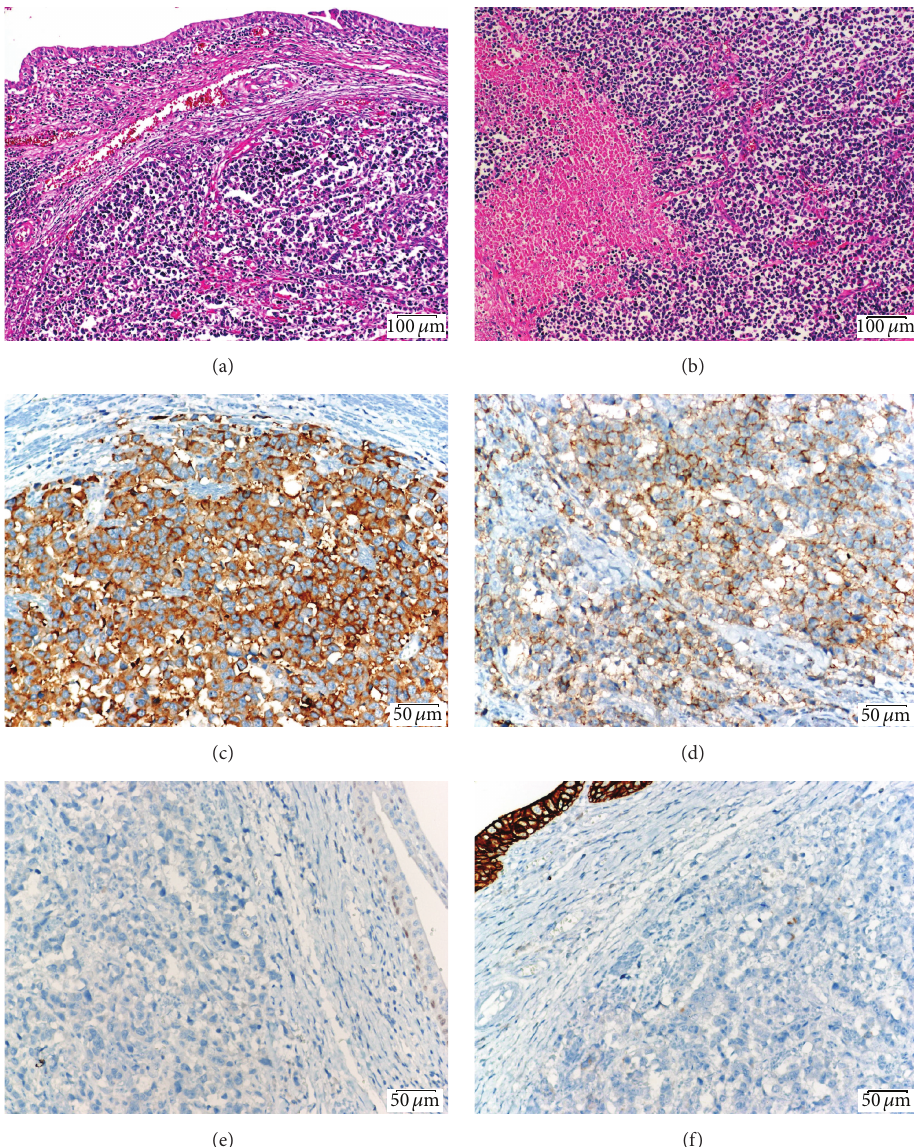
Figure 2: (a) Surface infiltrating urothelial lining laminated propria below shows the small round malignant tumor infiltration (Hematoxylin Eosin stain, × 100). (b) Multiple small round necrotic areas were seen in the malignant tumors (Hematoxylin Eosin stain, × 100). (c) The synaptophisin positivity in neoplastic cells (immunohistochemical stain, × 200). (d) Neoplastic cells in diffuse moderate expression of CD56 membranous (immunohistochemical stain, × 200). (e) This p53 weak expression in basal area is considered negative staining. (immunohistochemical stain, × 200). (f) In general the neoplastic cells negative CK-7 expression (immunohistochemical stain, ×